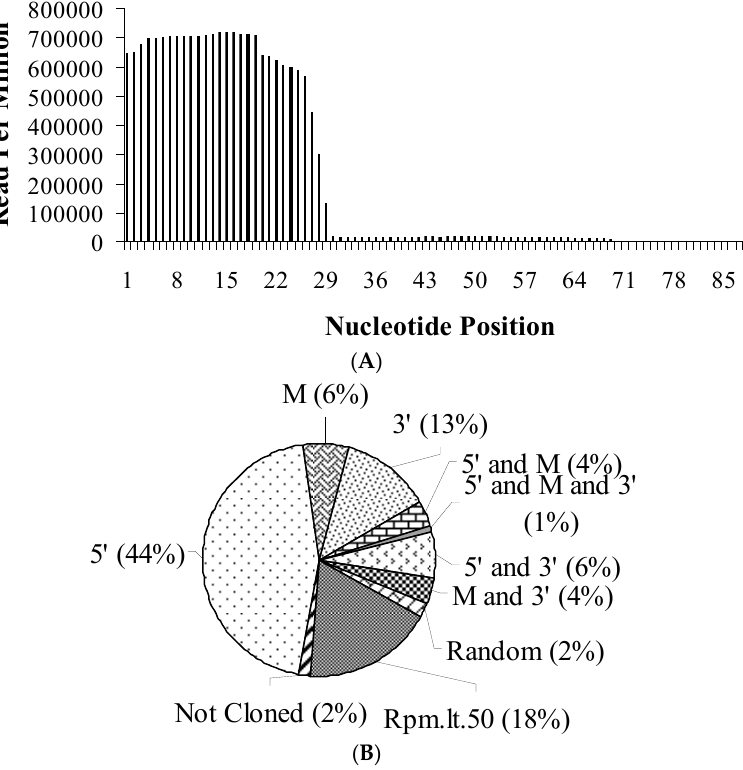
Figure 1. tRFs are detected primarily from the 5’-ends of tRNAs in Drosophila . ( A ) Cloning frequency of each nucleotide on a representative tRNA. All tRNA-derived fragments identified in unfractionated and fractionated samples were aligned to the tRNAs they originated from and the position of each nucleotide was determined relative to the 5’ end. The cloning frequencies of all nucleotides relative to the 5’-end were summed and graphed on a representative tRNA. ( B ) Percentage of tRNAs from which tRFs are generated. 103 tRNAs were folded into a cover leaf structure as determined by the tRNAScan-SE program [25]. Each tRNA was then divided into three main regions; 5’ (1–26 nt), M (middle, sequences flanking the region between the first and last 26 nt) and 3’(the last 26 nt). The frequency of each nucleotide position normalized to read-per-million was divided by the length of the fragments to obtain the relative expression ratio per nucleotide site on individual tRNAs. Based on the location of the reads, each tRF was assigned to a region on a reference tRNA (5’, middle (M) and 3’). For a tRF to be assigned to a tRNA region (e.g., 5’, middle or 3’), at least 2/3rd of the tRF must overlap that region. Rpm.lt.50—read-per-million is less than 50.